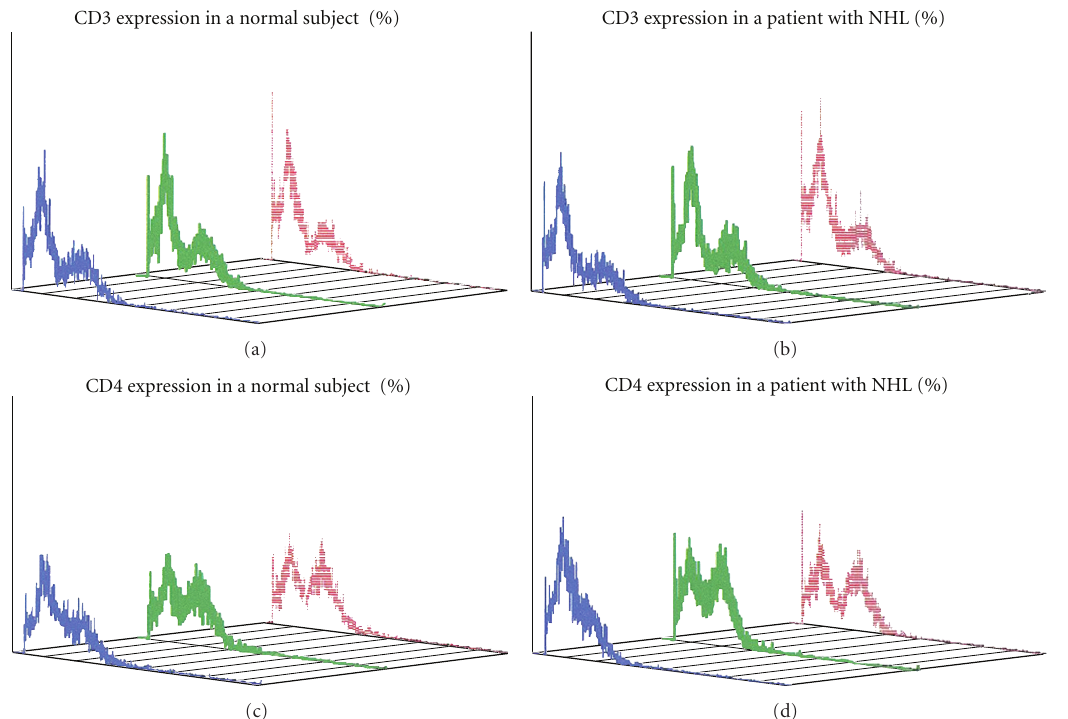
Figure 1: Flow cytometric analysis of CD3 and CD4 expressions in a normal individual and in a patient with NHL. Blue histograms represent untreated lymphocytes, green histograms represent lymphocytes treated with 10 μ g/mL of FR-91, and red histograms represent lymphocytes treated with 25 μ g/mL of FR-91. Flow cytometric analysis in (a) shows a reduction in CD3 antigen expression after exposure to 25 μ g/mL of FR-91, while an increase in both green and red histograms can be observed in the NHL patients (b). A similar pattern of CD4 expression can be observed both in the normal patient as well as in the NHL patient, being the expression of CD4 higher after treatment with 10 μ g/mL of FR-91 (d).